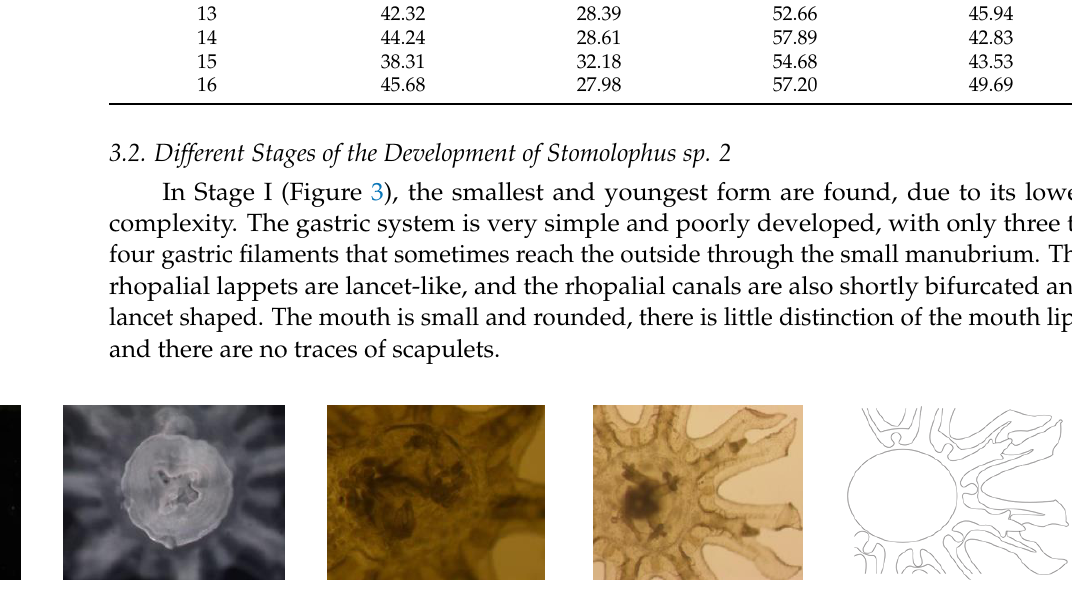
Figure 3. Stage I Ephyrae ( Stomolophus sp. 2). Without scapulets, mouth poorly developed (only mouth lips distinguishable, without papillae or faintly developed), gastric system poorly developed with only velar and rhopaliar canals, four gastric filaments, lancet-shaped lappets. No velar lappets.